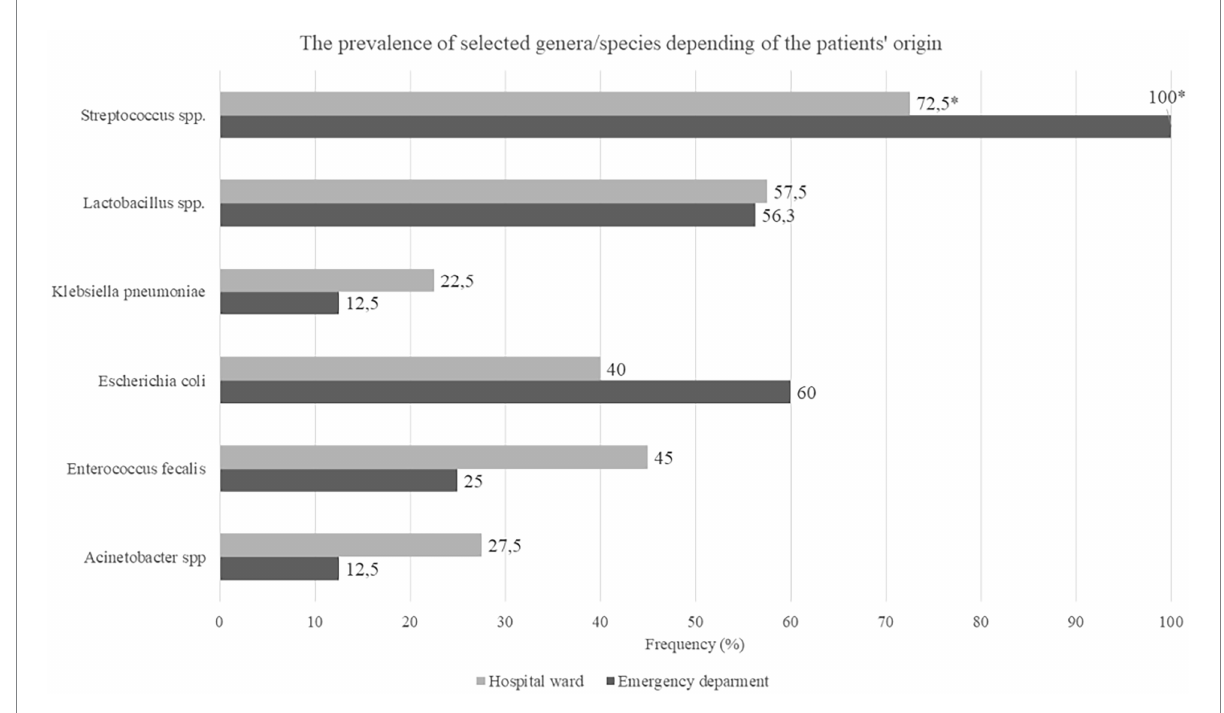
FIGURE 3 Number of patients with selected genera/species depending of the patients’s origin, N = 56, data presented as